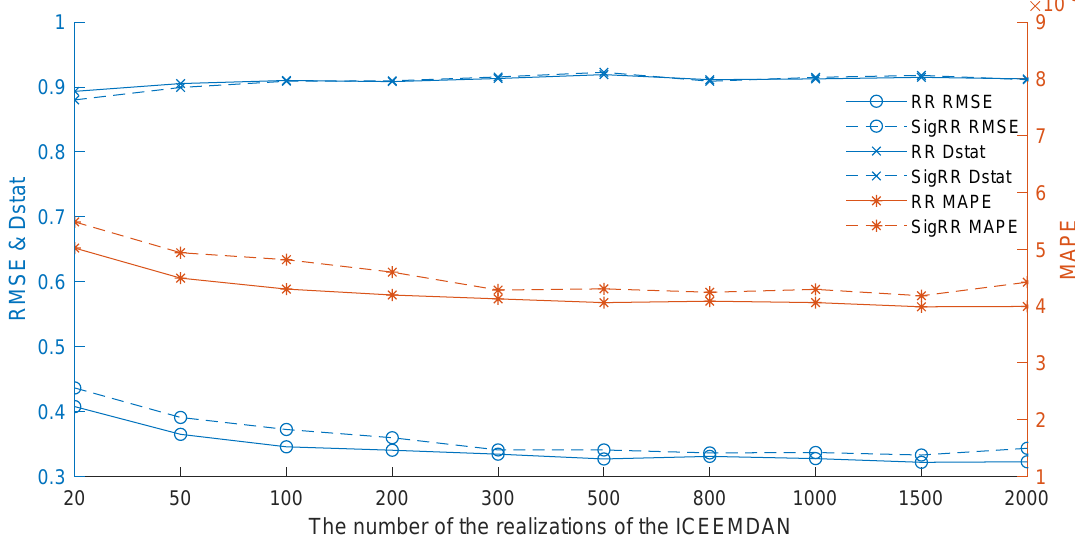
Figure 4. The impact of the number of the realizations in the ICEEMDAN by RR and